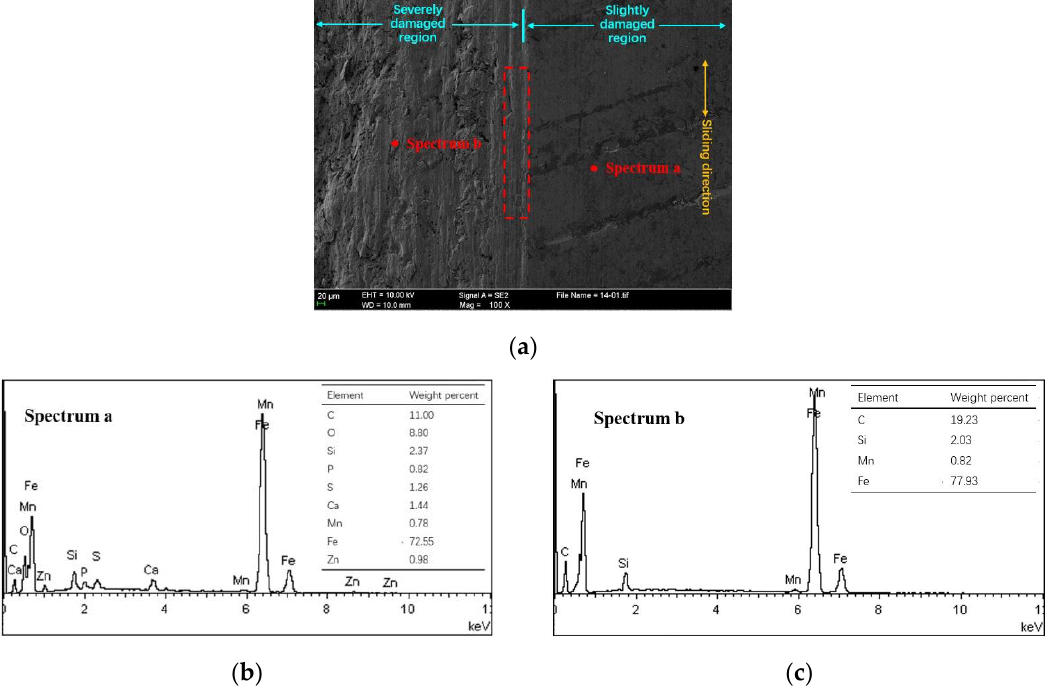
Figure 5. Scuffed cylinder liner surface and elemental content of NCM/Fe. ( a ) Scanning electron microscope (SEM) image; ( b ) EDS spectrum a; ( c ) EDS spectrum b .